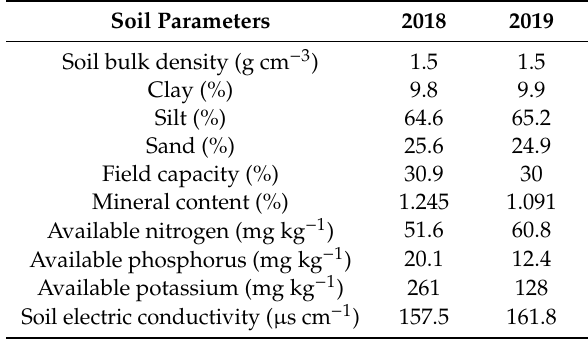
Table 1. Soil parameters of 0–90 cm soil layers before fertilization at Wuwei, Gansu Province, China, 2018 and